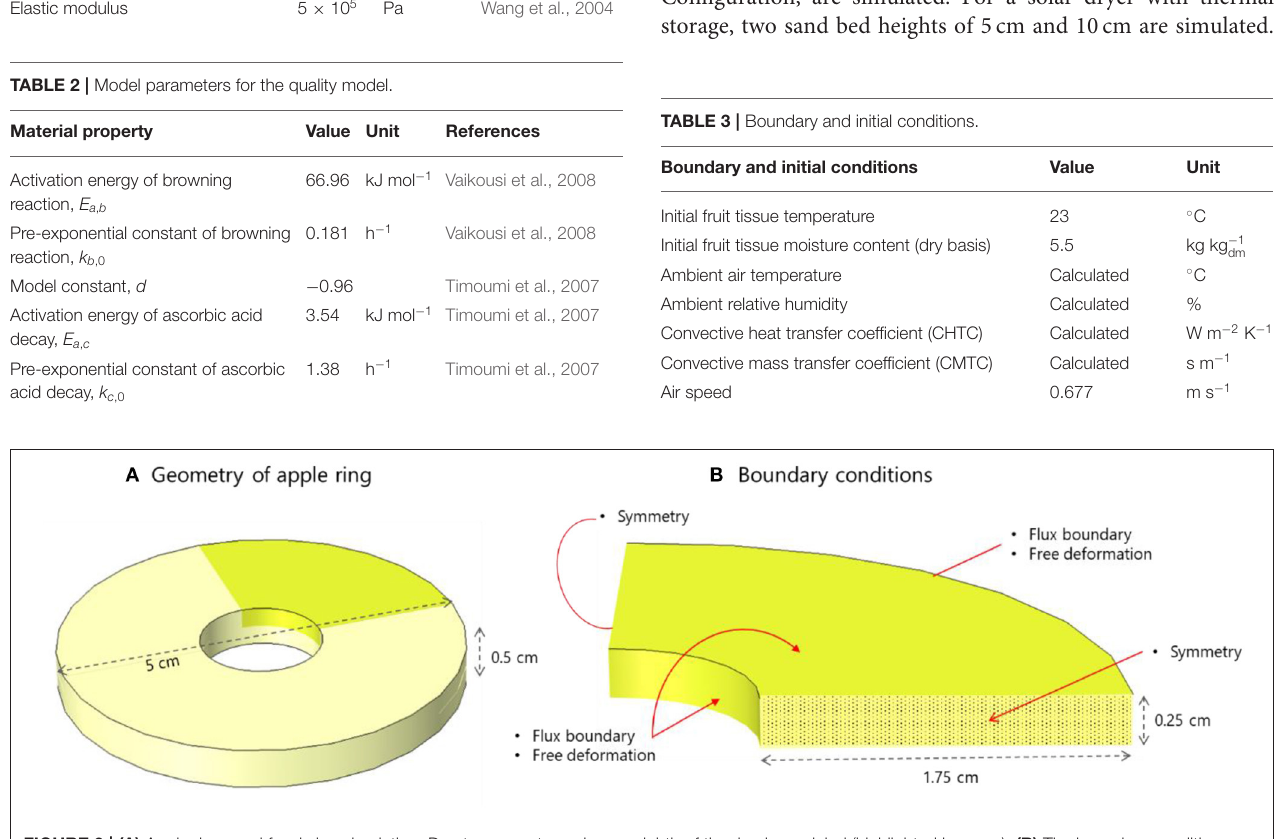
FIGURE 3 | (A) Apple ring used for drying simulation. Due to symmetry, only one-eighth of the ring is modeled (highlighted in green). (B) The boundary conditions imposed on the computational domain.